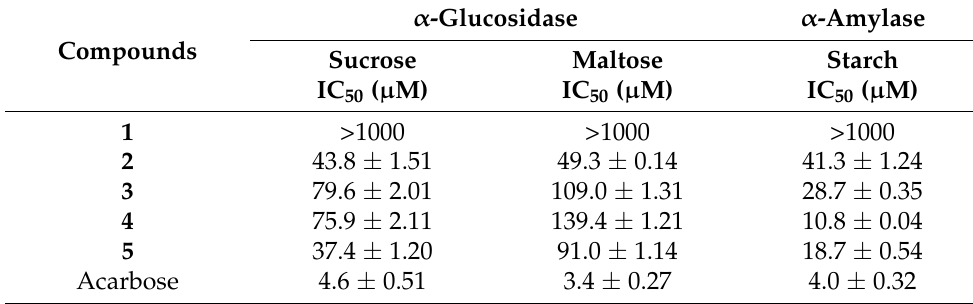
Table 4. The in vitro antidiabetic activity of Compounds 1 – 5